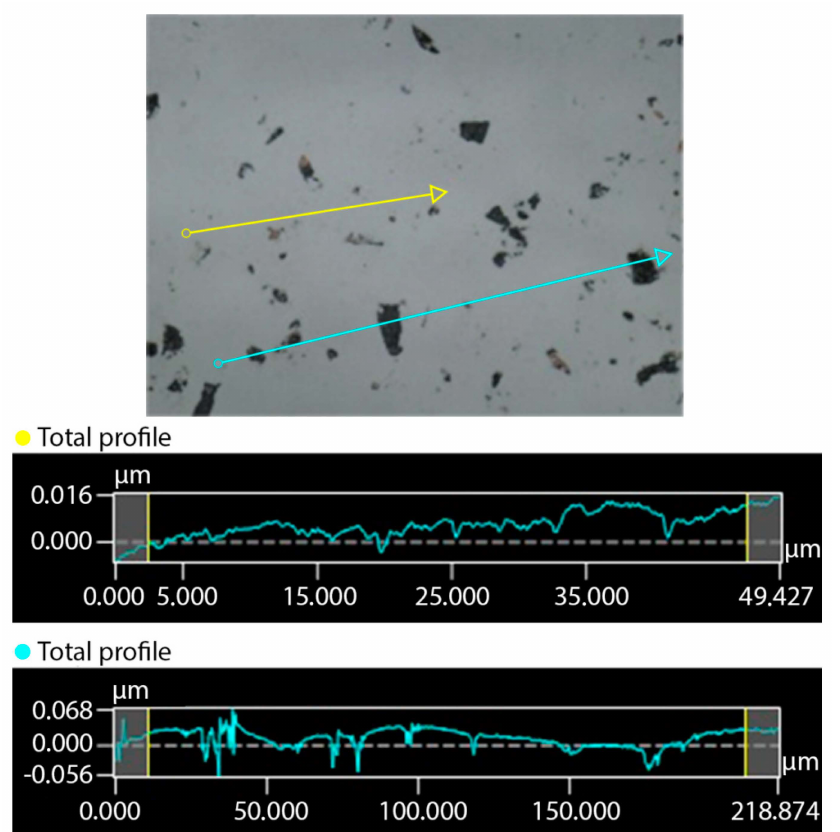
Figure 3. Roughness of the tungsten in-line sample: yellow line with small surface unevenness; blue line with large surface unevenness ( × 150). Adapted from [15] with kind permission of Brno University of Technology.